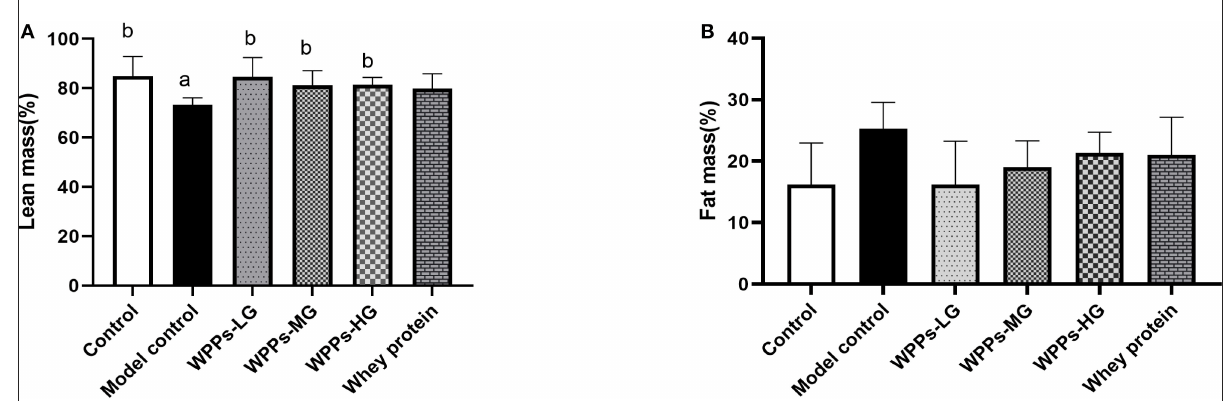
FIGURE2 Effects of WPPs on body composition including lean mass (A) and fat mass (B) . Data are expressed as means ± SD ( n = 6). a p < 0.05 indicates significant difference vs. the control group; b p < 0.05 indicates significant difference vs. the model group. Whey protein group at a dose of 1.5 g/kg; WPPs-LG, whey protein peptides low-dose group at a dose of 0.3 g/kg; WPPs-MG, whey protein peptides medium-dose group at a dose of 1.5 g/kg; WPPs-HG, whey protein peptides high-dose group at a dose of 3.0